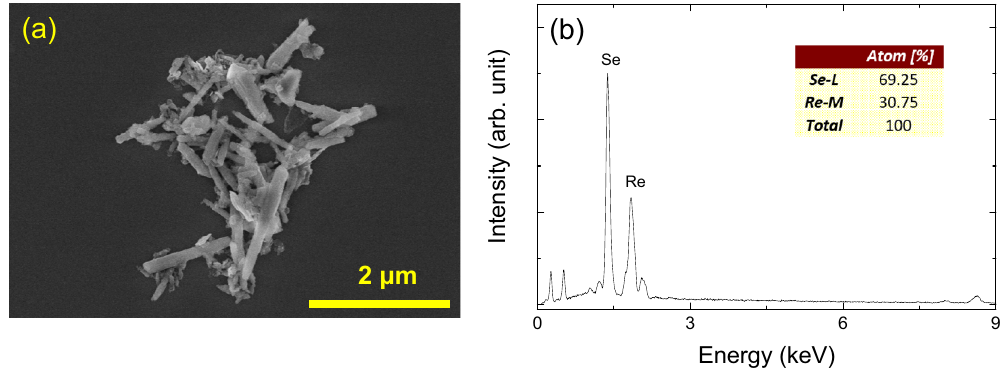
Figure 1. ( a ) An SEM image and ( b ) an EDS spectrum of ReSe 2 particles.